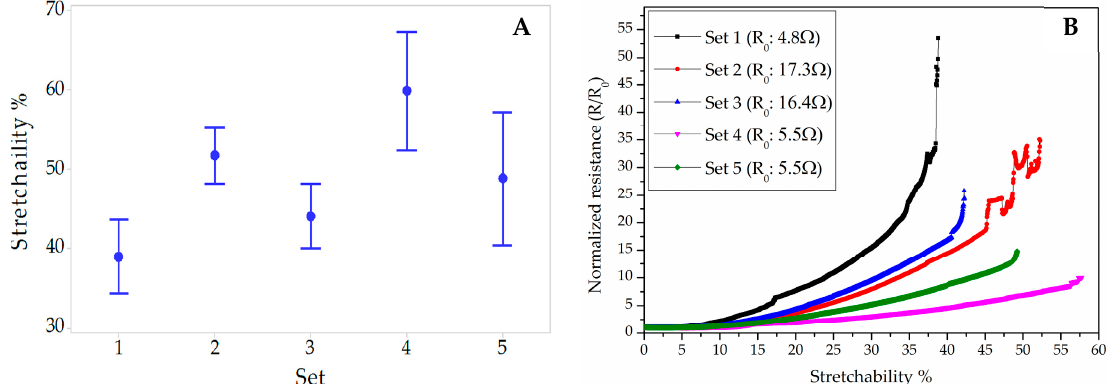
Figure 8. The stretchability feedback of interconnects. ( A ) An interval plot of the stretchability of different sets of samples: (1) non ‐ encapsulated, (2) partially ink ‐ encapsulated, (3) entirely ink ‐ encapsulated, (4) partially TPU ‐ encapsulated, and (5) entirely TPU ‐ encapsulated; the mean values are 38.9%, 51.7%, 44.01%, 59.84%, and 48.81%, respectively. ( B ) Comparison of normalized resistances of a typical performance of each samples. Initial resistances (R 0 ) are 4.8, 17.3, 16.4, 5.8, and 5.5 Ω for sets 1–5, respectively.